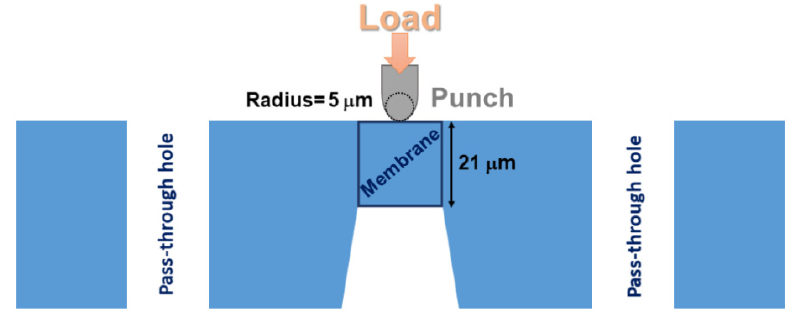
Figure 9. Scheme of the micro-punch test carried out on the FIB-milled membranes.